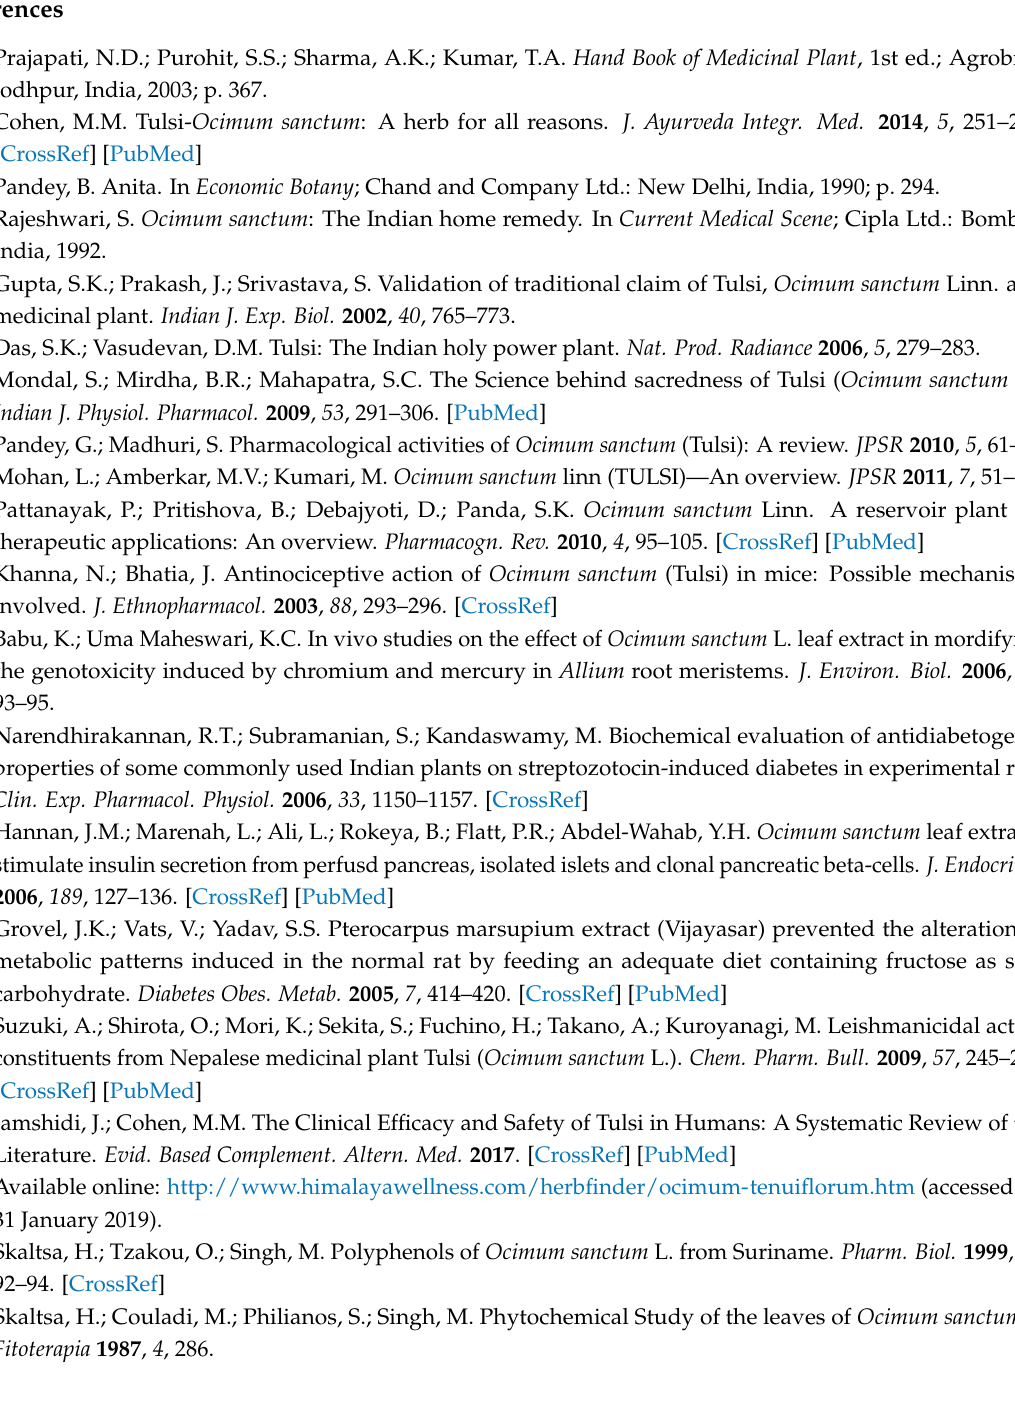
Table S1: 1 H-NMR of 6 (CD 3 OD, 400 MHz); Table S2: 13 C-NMR of 6 (CD 3 OD, 400 MHz); Figure S1: 1 H-NMR spectrum of 6 (CD 3 OD, 400 Hz); Figure S2: COSY spectrum of 6 (CD 3 OD, 400 Hz); Figure S3: 13 C NMR spectrum of 6 (CD 3 OD, 400 Hz); Figure S4: HSQC spectrum of 6 (CD 3 OD, 400 Hz); Figure S5: HMBC spectrum of 6 (CD 3 OD, 400 Hz); Figure S6: Most important HMBC signals of compound 6